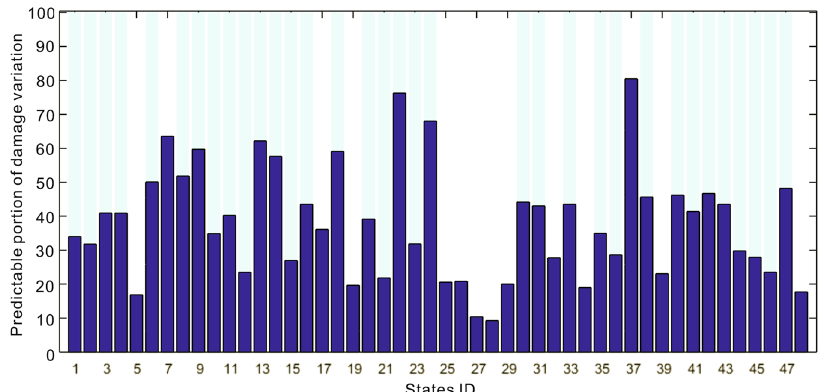
Figure 7. Portion of flood damage variation explained by the statistical model. The light blue bar indicates the state where flood damage variations can be predicted significantly at the 90% confidence level. Figure was created using software MATLAB 2015a